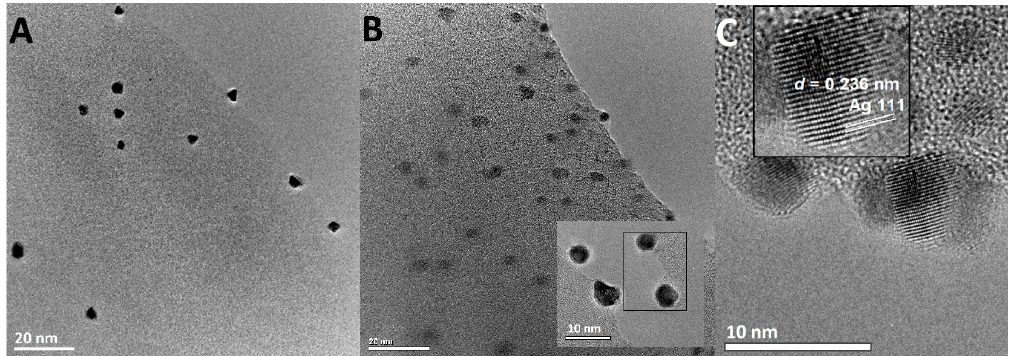
Figure 10. ( A ) TEM images of the AgNP extracted from BP/AgP sample as free AGNP. ( B ) TEM image of a small part of solid surface with AgNP (BP/AgP), scale bar = 20 nm. ( C ) the HRTEM image of selected AgNP with visible lattice planes and the interplanar spacing d = 0.236 nm corresponding to the Ag(111) lattice plane.